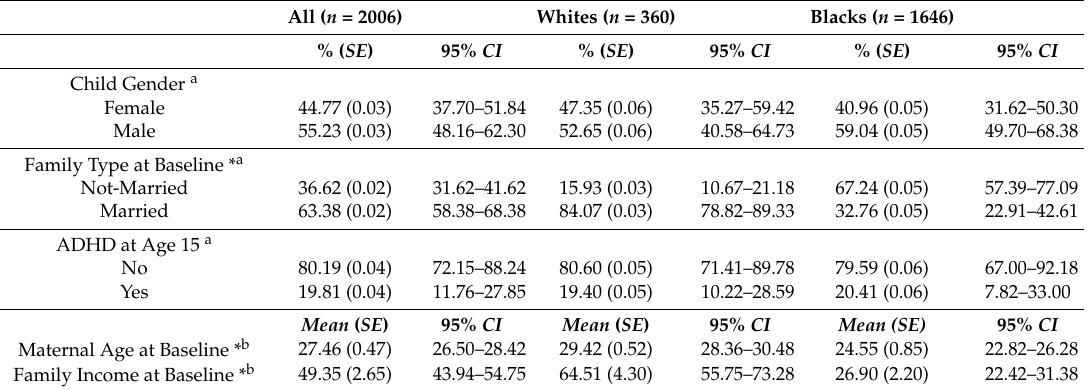
Table 1. Sociodemographic characteristics in the pooled sample and across race/ethnic groups. All ( n = 2006) Whites ( n = 360) Blacks ( n =